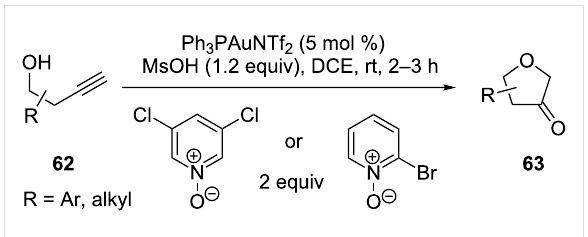
Scheme 12: Expedient synthesis of dihydrofuran-3-ones.